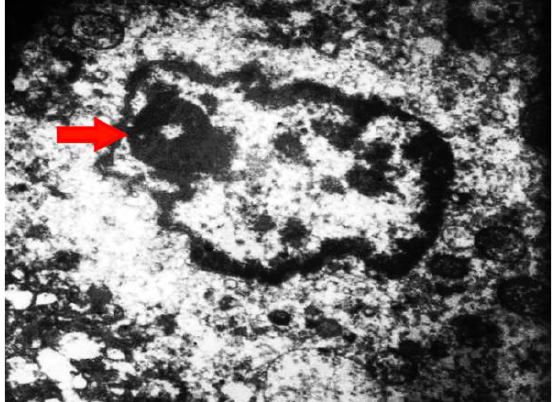
Fig. 2. Electron microscopy showed the presence of nucleolus in the nucleus of diseased hepatocyte and swollen mitochondria; (Original magnification ×5,000) (Courtesy of Dr. Mitra Rezai,